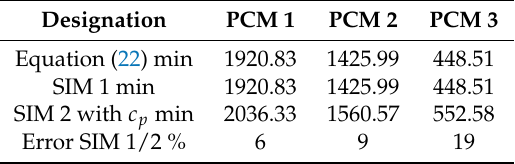
Table 4. Comparison of the total solidification times.